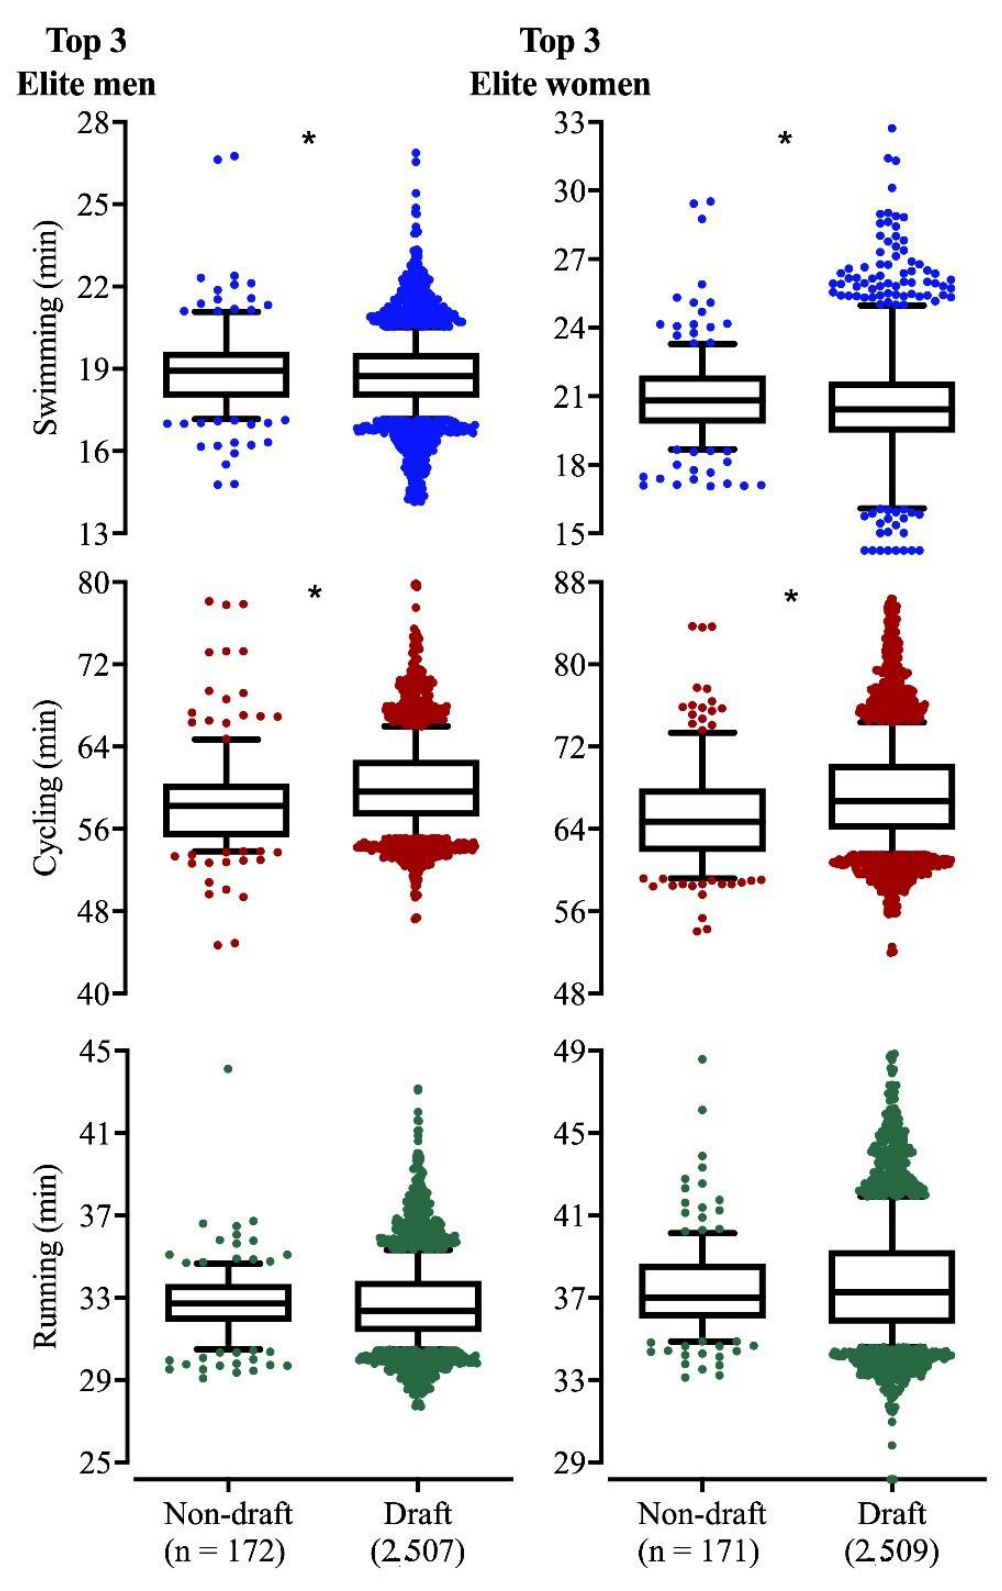
Figure 2. Average race times of each discipline (swim; cycle; run) of the top three finishers between draft (2000–2019) and nondraft periods (1989–1999). *: p <